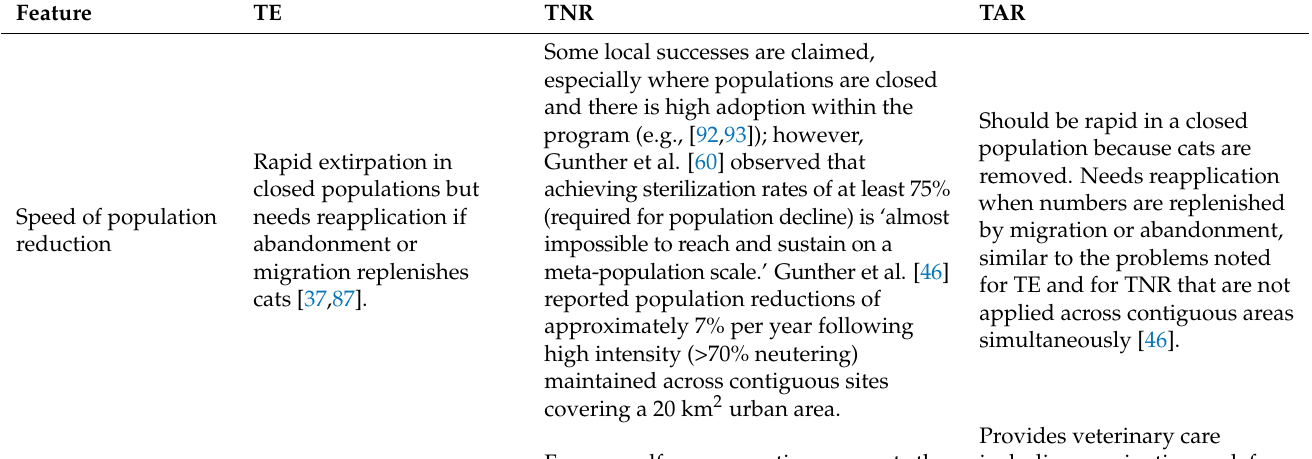
Table 2. Comparisons of the main features of trap and euthanize (TE), trap–neuter–return (TNR), and trap–assess–resolve (TAR) for managing populations of unowned